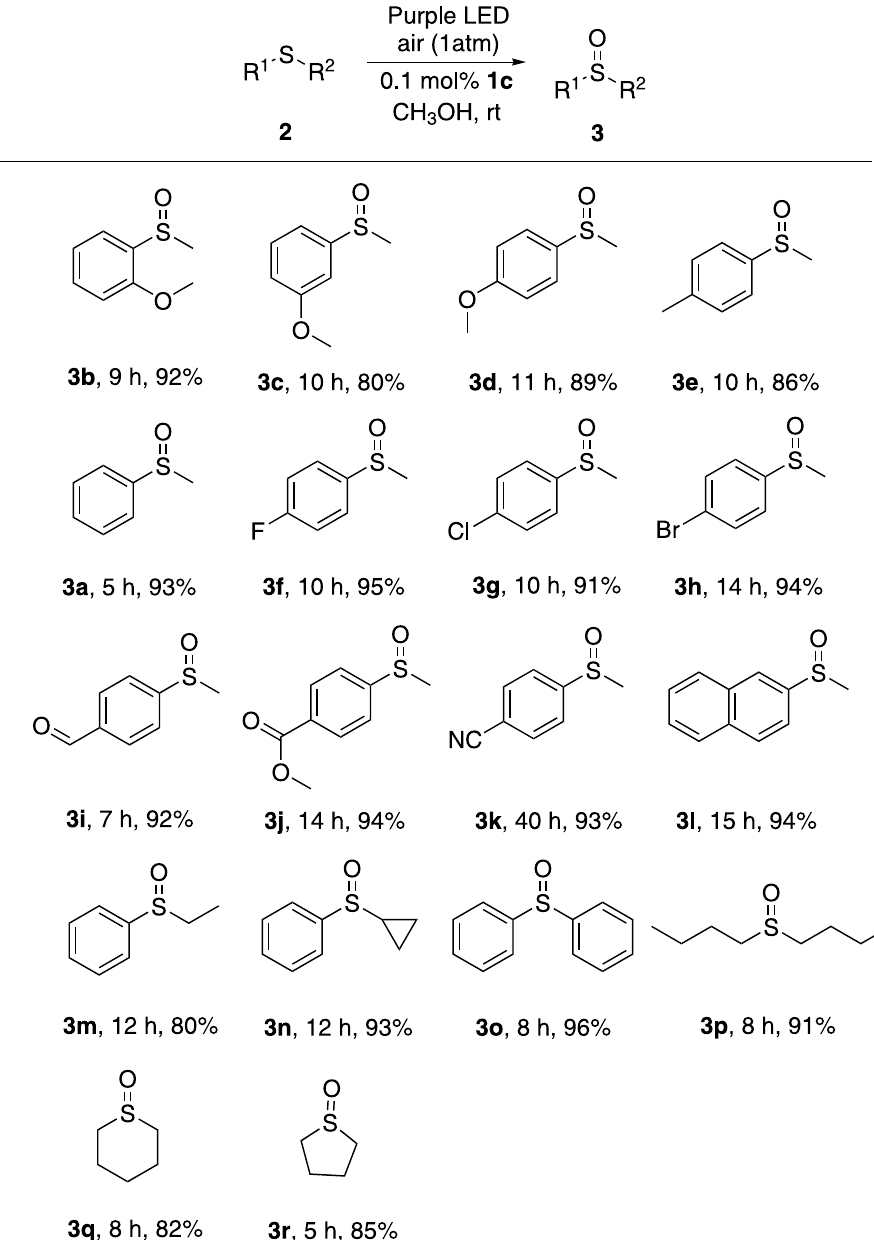
Figure 2. Photo oxidation under Condition A a . a All reactions were carried out using 2 (1 mmol) and 1c (0.1 mol%) in CH 3 OH (5 mL) irradiated by a purple LED light at rt under air atomsphere. Isolated yield was